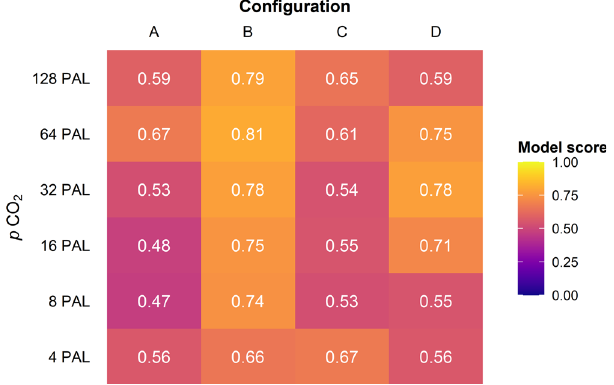
Fig. 6 Data – model agreement scores for lower Cambrian lithology data and FOAM GCM simulations, incorporating palaeogeographic uncertainty of 200 km. The scores compare Köppen – Geiger climate classes assigned to climatically sensitive rock types with the climate classes produced under each GCM simulation, following the agreement scoring equation of ref. 49 (see ‘ Methods ’ ). Simulations were run with present-day orbital Whilst the data – model agreement scores for con fi guration B are consistently high across all p CO 2 conditions, the highest- scoring Antarctocentric con fi guration (D) performs best in the highest of the intermediate p CO 2 simulations that were pre- viously retained (i.e. at 32 PAL). This p CO 2 value is in line with the higher estimates of carbon cycle models (Supplementary Table 1) 37,39,41 . The SSTs simulated for con fi guration D at 32 PAL p CO 2 are also consistent with inferences from isotopic SST estimates for high-latitude Avalonia of approximately 20 °C – 25 °C 7 , while the 8 and 16 PAL p CO 2 runs simulate SSTs that are too cold. In con fi guration C, Avalonia is positioned at the South Pole and remains too cold under all except the 128 PAL